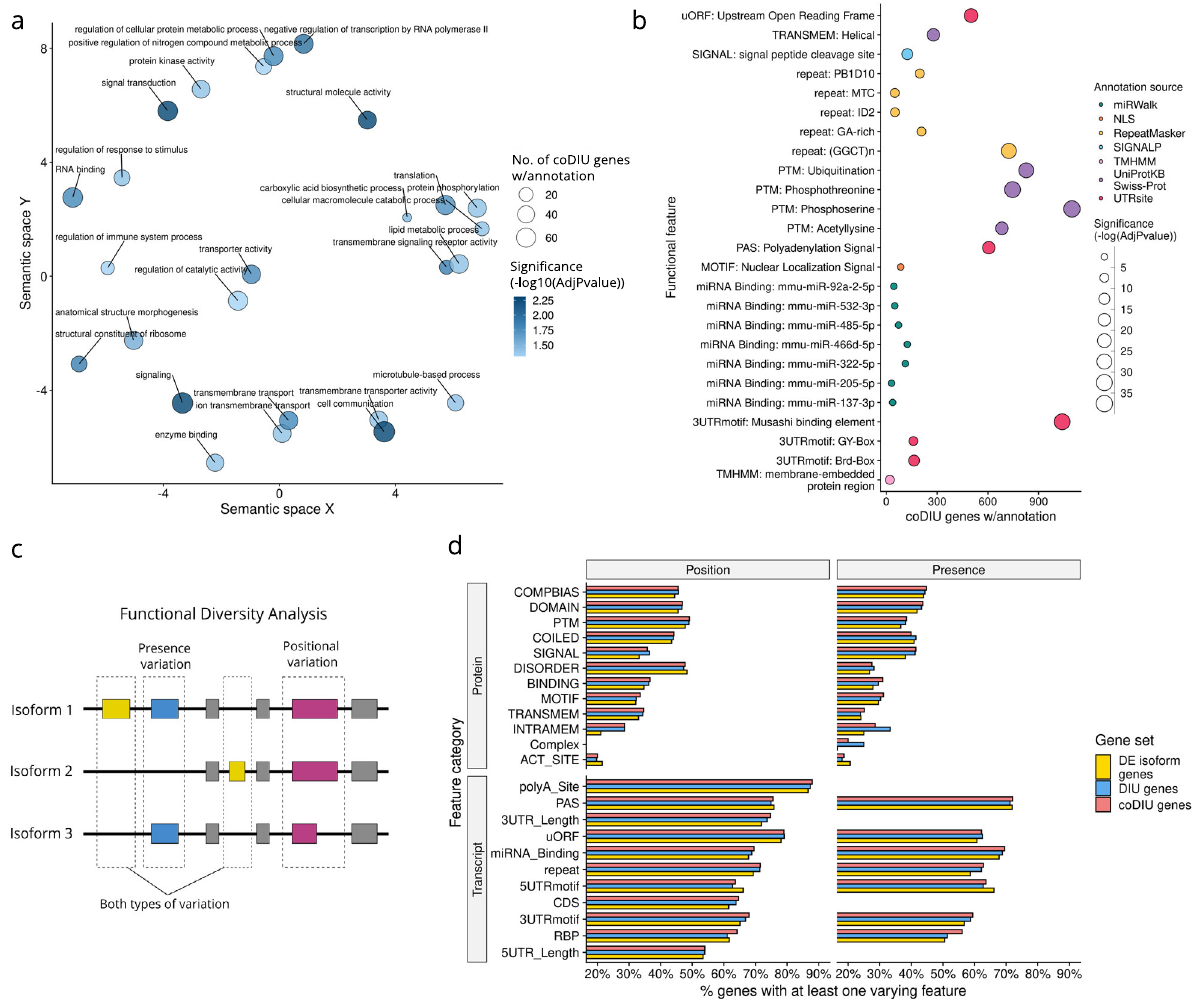
Fig. 5 Functional analysis of DIU and coDIU genes. a Gene Ontology (GO) Functional Enrichment results for co-Differential isoform Usage (coDIU) vs genes with Differential Isoform Usage (DIU) of isoforms. Only terms obtained after Revigo fi ltering are shown. x and y -axis indicate semantic similarity, as de fi ned by Revigo (see “ Methods ” ). Dot size represents total coDIU genes annotated for each GO term. Dot color represents signi fi cance, i.e., − log10(adjusted p -value). b Functional Enrichment of positional features for coDIU vs DIU genes. x -axis indicates the total number of coDIU genes including the tested annotation feature, y -axis shows functional features. Dot color represents the functional category (i.e., annotation source database) and dot size represents − log(adjusted p -value). c Schematic representation of tappAS ’ Functional Diversity Analysis (FDA). The genomic position and present/absence criteria, both of which can be used to detect functional variation among isoforms from the same gene (i.e., label the gene as varying ), are depicted. d FDA results for DE isoform, DIU, and coDIU genes. y -axis shows transcript and protein functional categories (see Supplementary Note for category de fi nition information). x -axis shows the percentage of genes including at least one feature annotation from each of the categories that are detected as functionally varying . Both FDA criteria are shown (position: left grid column, presence: right grid column). CoDIU genes show the largest level of functional